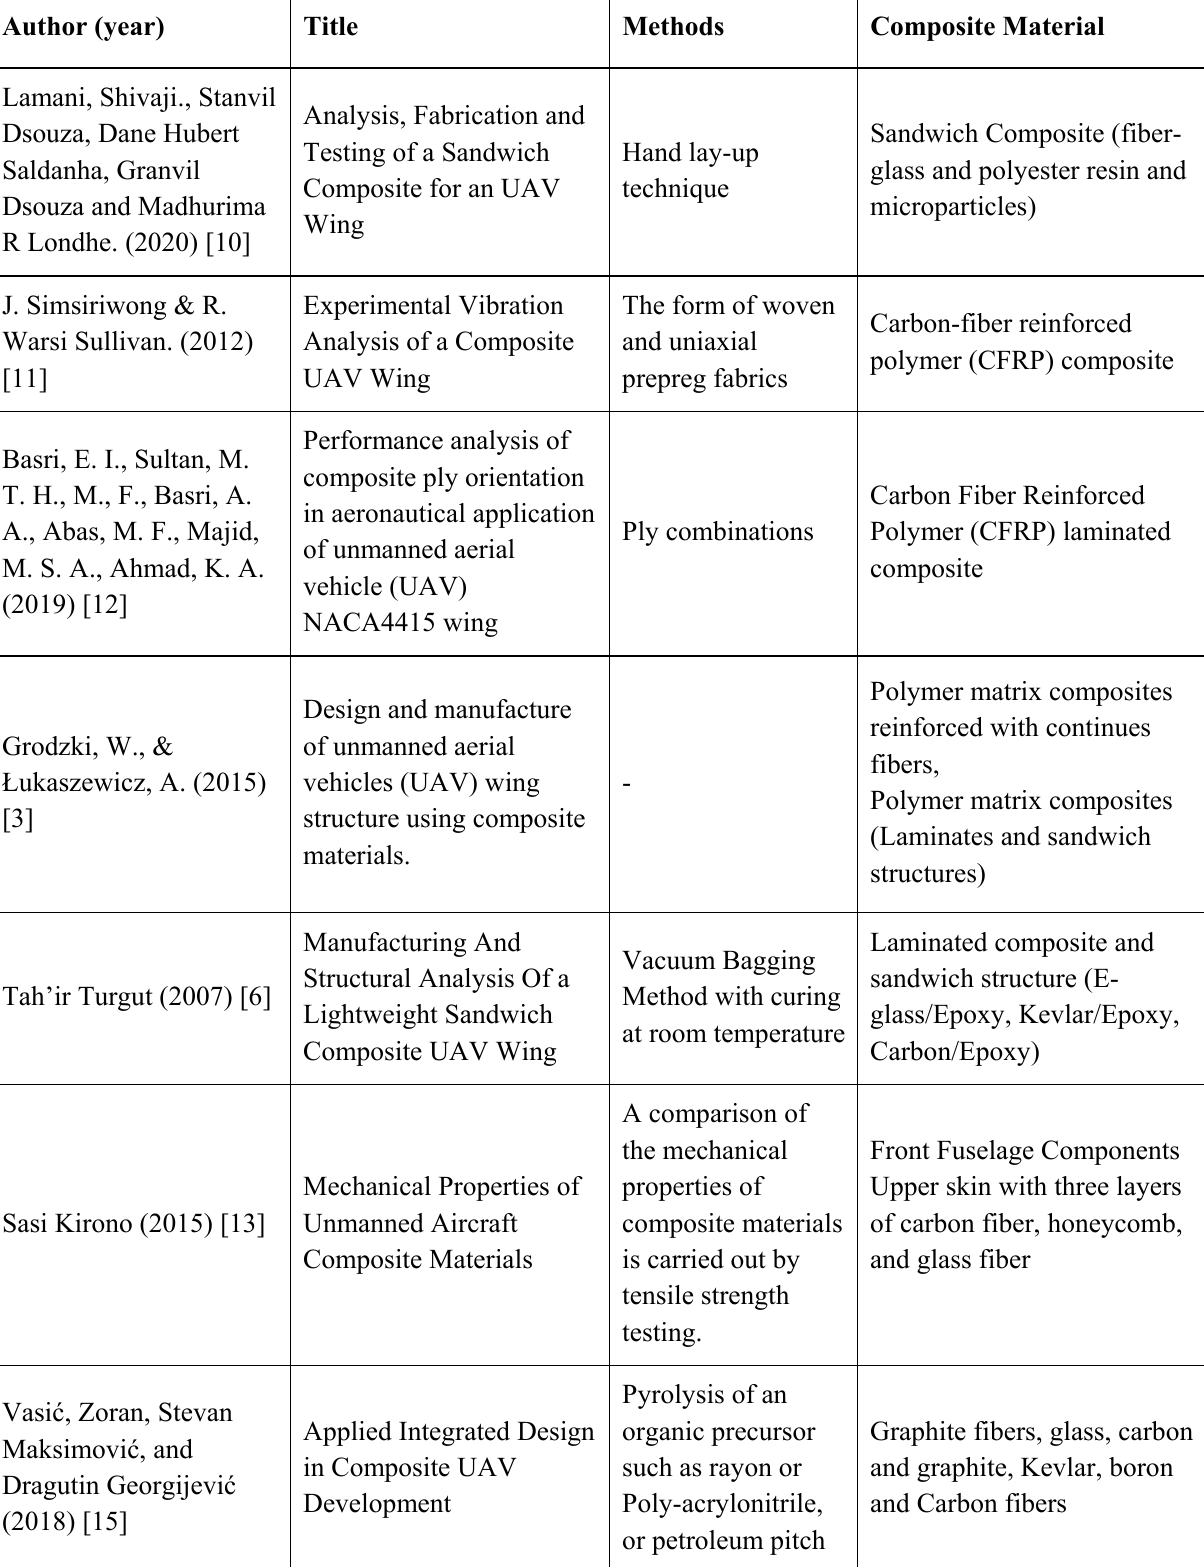
Table 1. Previous research on material utilization for UAV